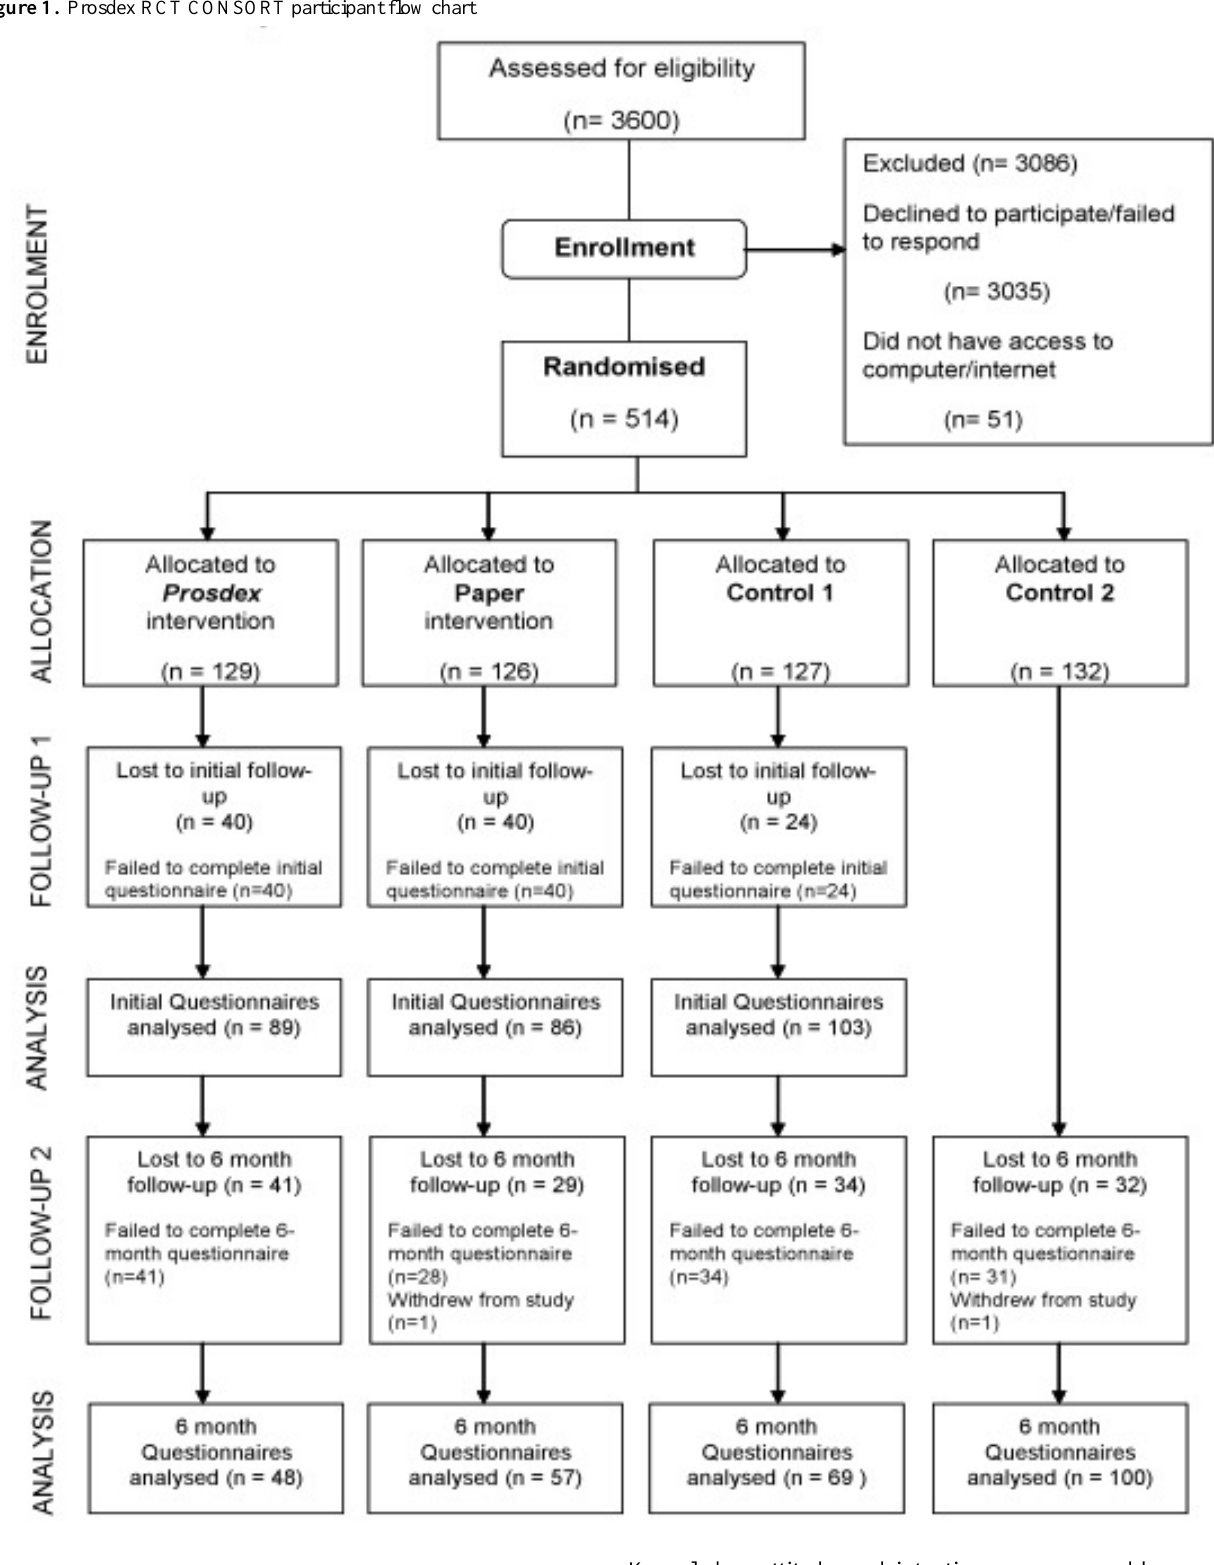
Figure 1. Prosdex RCT CONSORT participant flow